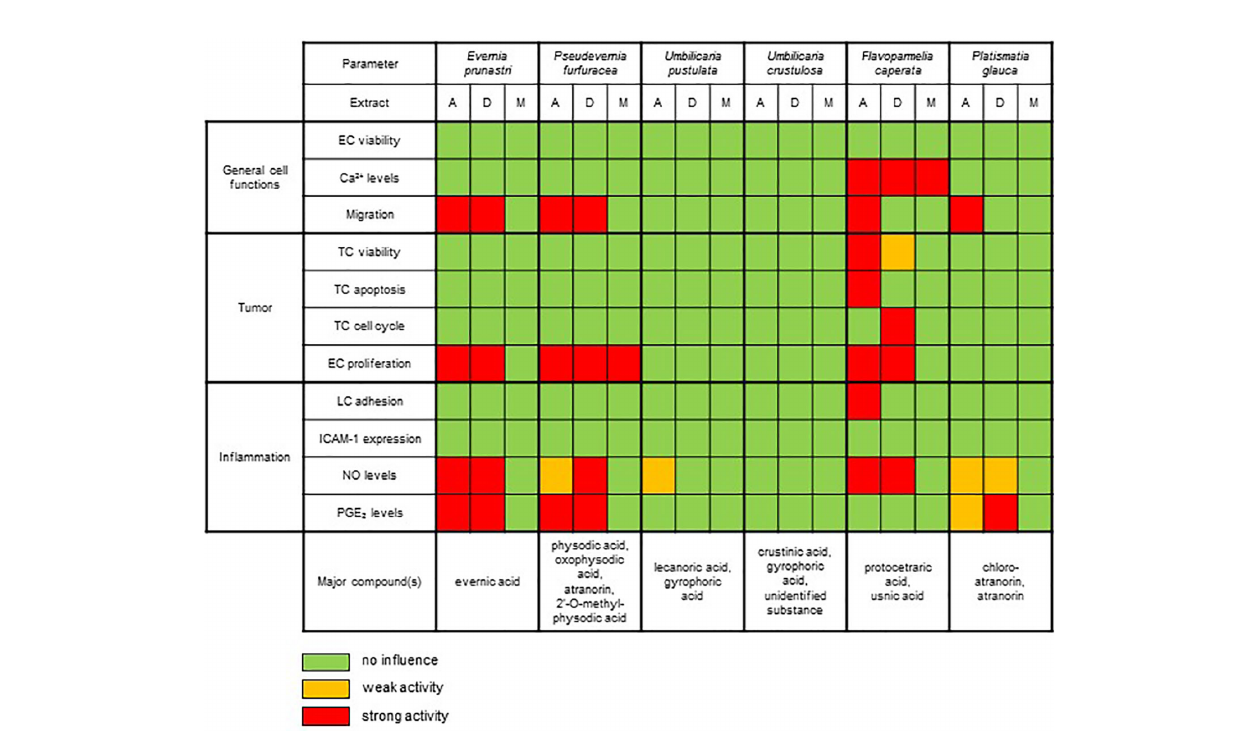
FIGURE 6 | Summary of the effects of the UV-absorbing lichen extracts in the various biochemical and functional test